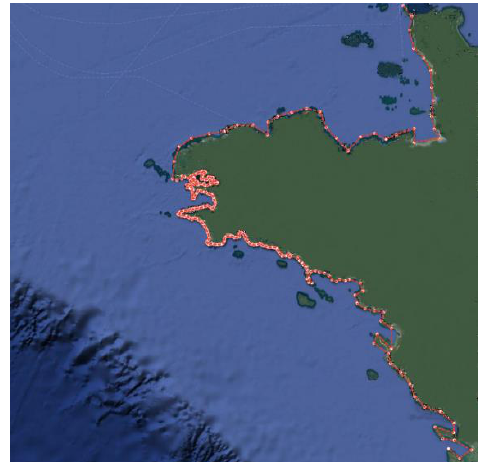
Figure 6. Marks on the coastline.